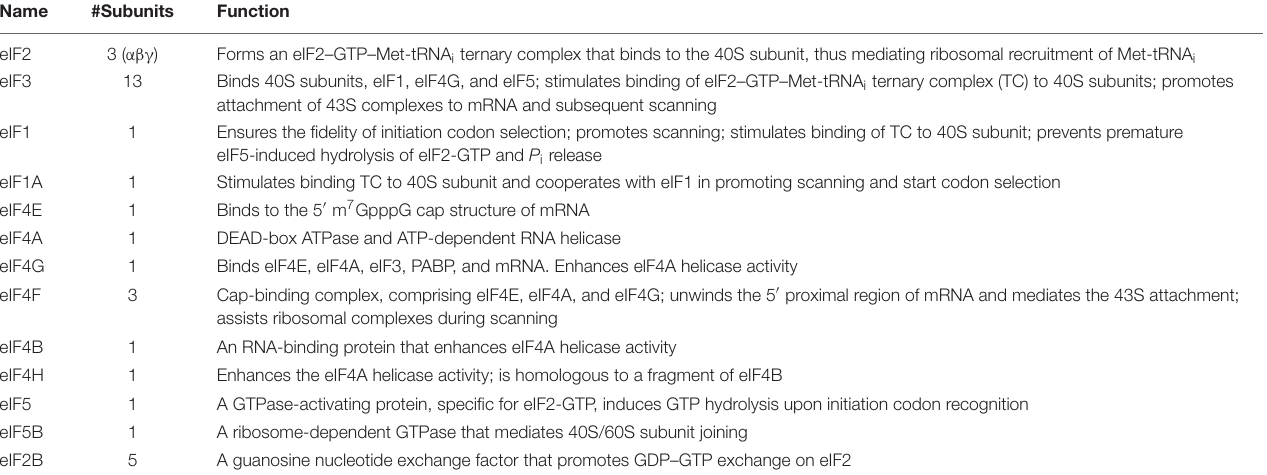
TABLE 1 | List of eukaryotic initiation factors (eIFs) and their function (adapted from Jackson et al., 2010). Name #Subunits